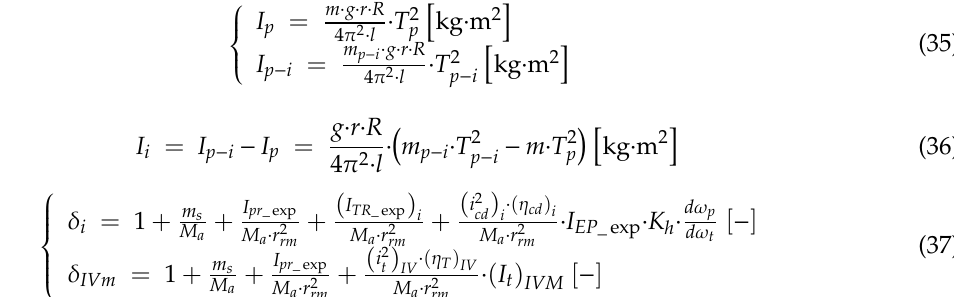
Table 6. Experimental data obtained with the three-wire pendulum method.